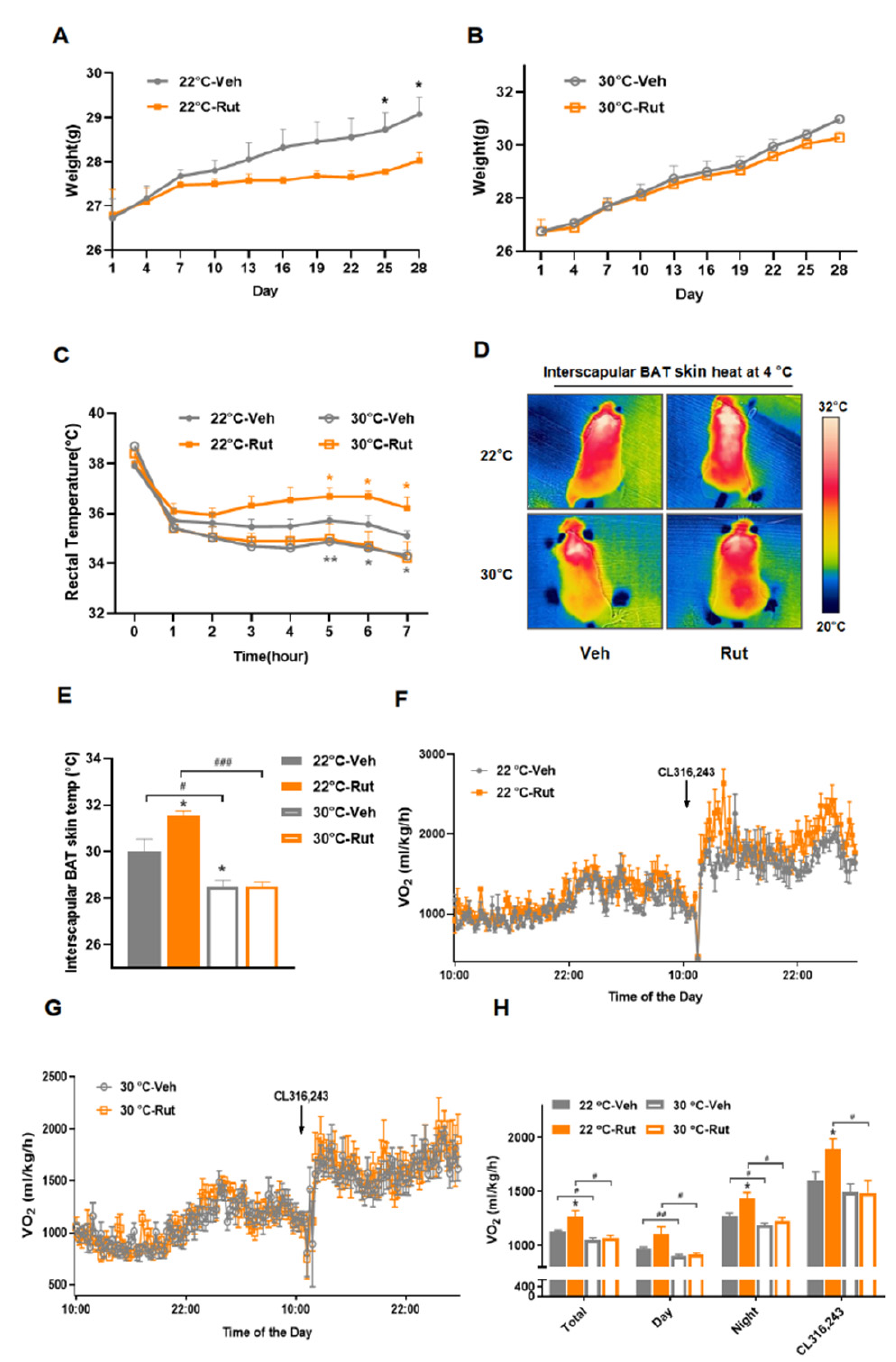
Figure 5. Thermogenic effects induced by Rut treatment are ablated in thermoneutral conditions. ( A , B ) Body weights of HFD-fed mice treated with vehicle or Rut housed at 22 ◦ C ( A ) or 30 ◦ C ( B ). ( C ) Rectal temperature changes of mice were recorded every hour during cold stimuli. ( D ) Representative infrared thermal images of mice after cold exposure. ( E ) Quantification of interscapular BAT skin temperatures of 22 ◦ C or 30 ◦ C mice treated with vehicle or Rut. ( F , G ) The changes in O 2 consumption of mice acclimated at 22 ◦ C ( F ) and 30 ◦ C ( G ). ( H ) Assessment of average O 2 consumption. n = 5 per group. Data are presented as the means ± SEM. * p < 0.05, ** p < 0.01, Rut group versus vehicle group; # p < 0.05, ## p < 0.01, ### p < 0.001, 30 ◦ C group versus 22 ◦ C group by Student’s t -test.